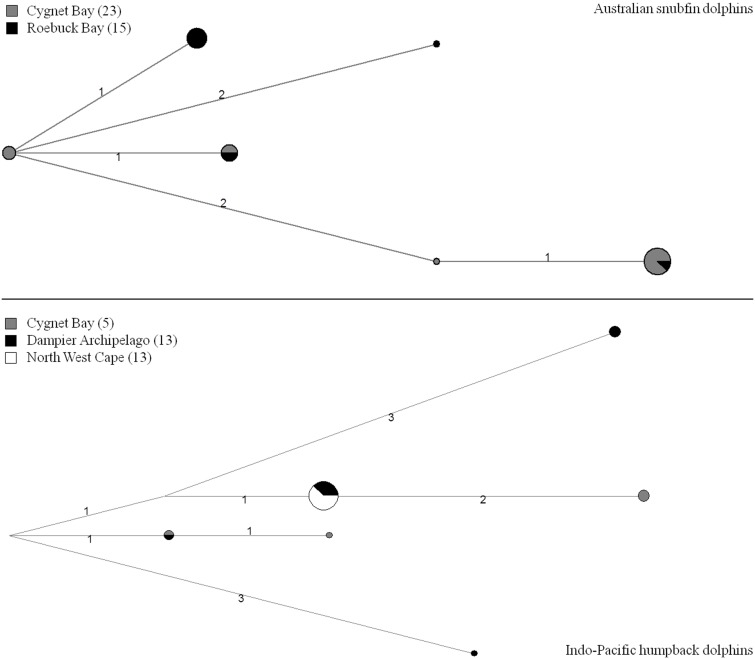
mtDNA networks for snubfin and humpback dolphins.Sample sizes are shown in parentheses. Branch numbers indicate the number of nucleotide differences between mtDNA haplotypes.